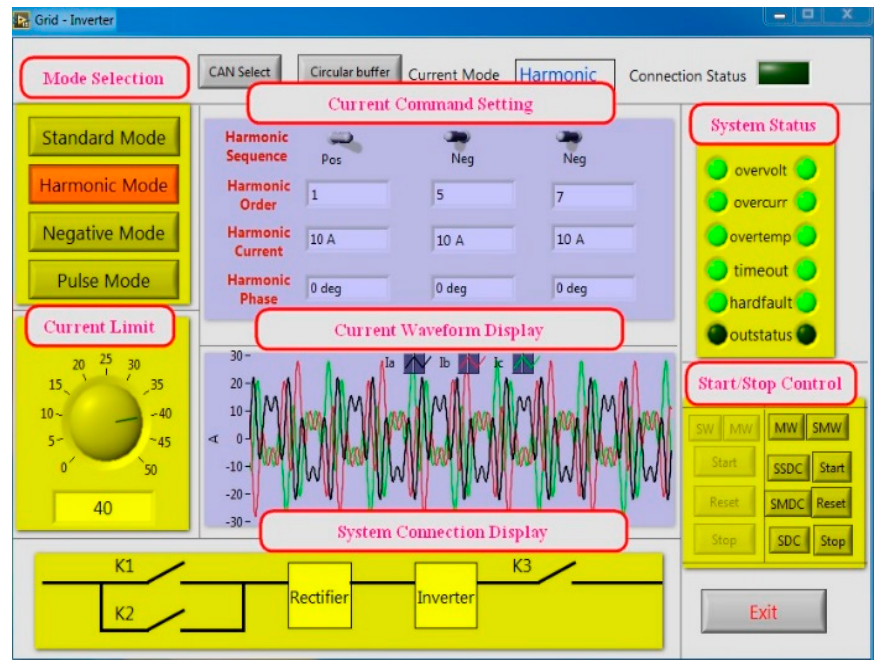
Figure 8. The graphical user interface for the experimental setup.